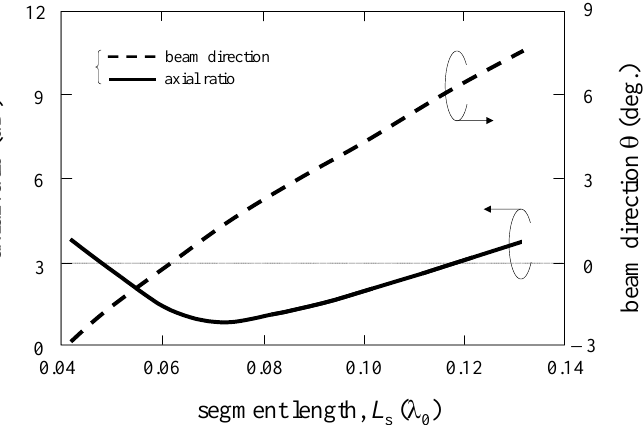
Figure 3. Simulated beam direction and axial ratio versus segment length L s for a bent line antenna with N = 12.